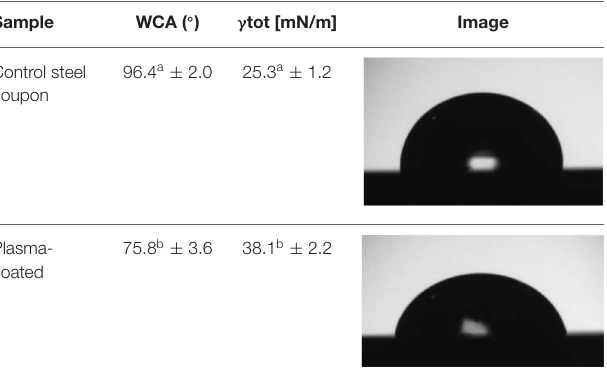
TABLE 4 | Effect of plasma deposition on water contact angle (WCA) and surface free energy ( γ tot) values of steel coupons